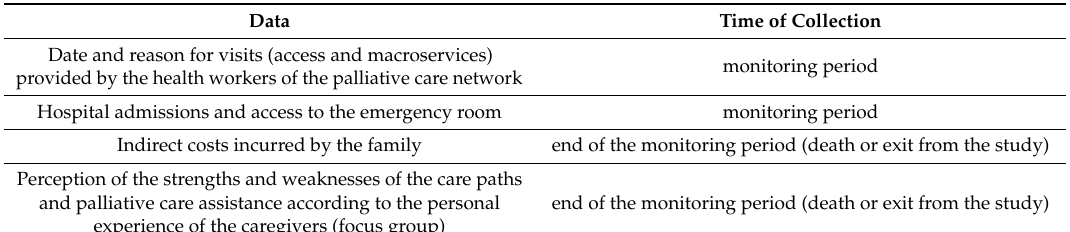
Table 1. Additional data